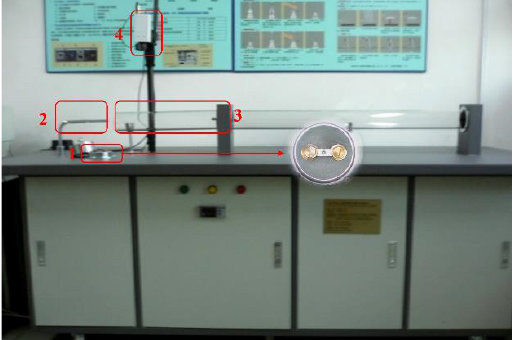
Figure 1. Pulverized coal safety measurement equipment, 1: Pulverized coal heating unit; 2: pulver- izer coal injector; 3: glass tube; 4: image detector